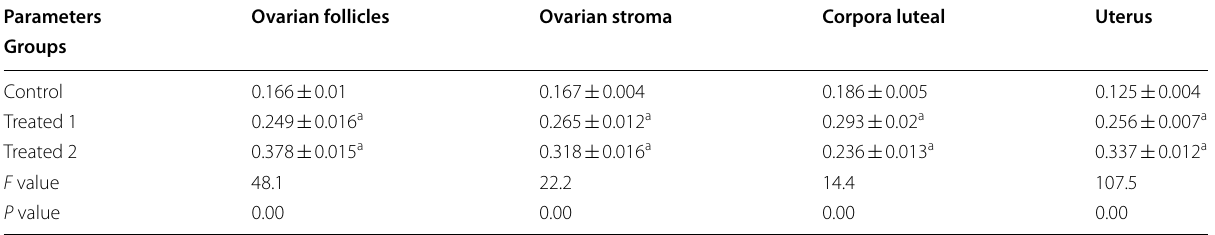
O NPs on immunohistochemistry 3 4